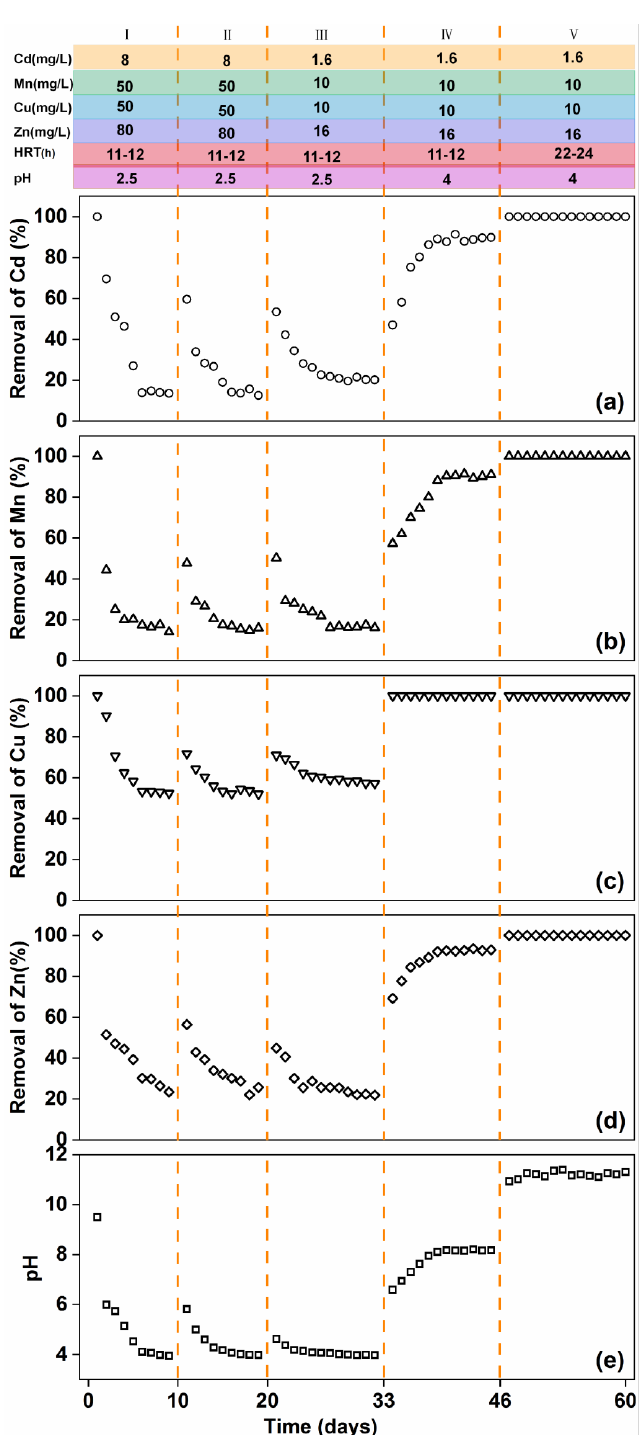
Figure 4. Time–dependent removal of ( a ) Cd, ( b ) Mn, ( c ) Cu and ( d ) Zn, and ( e ) pH from simulated acid mine drainage by RMCP under different conditions.